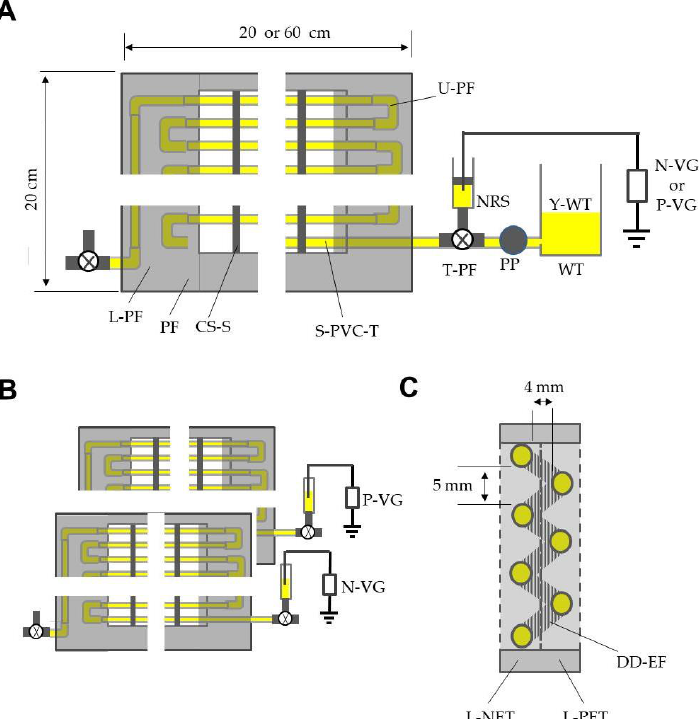
Figure 2. ( A ) A layer of soft polyvinyl chloride (S-PVC) tubes electrified with negatively or positively charged yellow-colored water. ( B ) Two layers of S-PVC tubes oppositely electrified with charged water. ( C ) Construction of the double-charged dipolar electric field producer (DD-FP), which was constructed by coupling two layers of S-PVC tubes that had been oppositely electrified (cross-sectional view). Abbreviations: L-PF, L-shaped pipe fitting; PF, polypropylene frame; CS-S, comb-shaped polypropylene spacer; S-PVC-T, soft polyvinyl chloride tube; U-PF, U-shaped pipe fitting; NRS, needle-removed syringe; T-PF, T-shaped pipe fitting; WT, water tank; PP, peristaltic pump; Y-WT, yellow-colored water; N-VG, negative voltage generator; P-VG, positive voltage generator; L-NET, layer of negatively electrified tubes; L-PET, layer of positively electrified tubes; DD-EF, double-charged dipolar electric field.